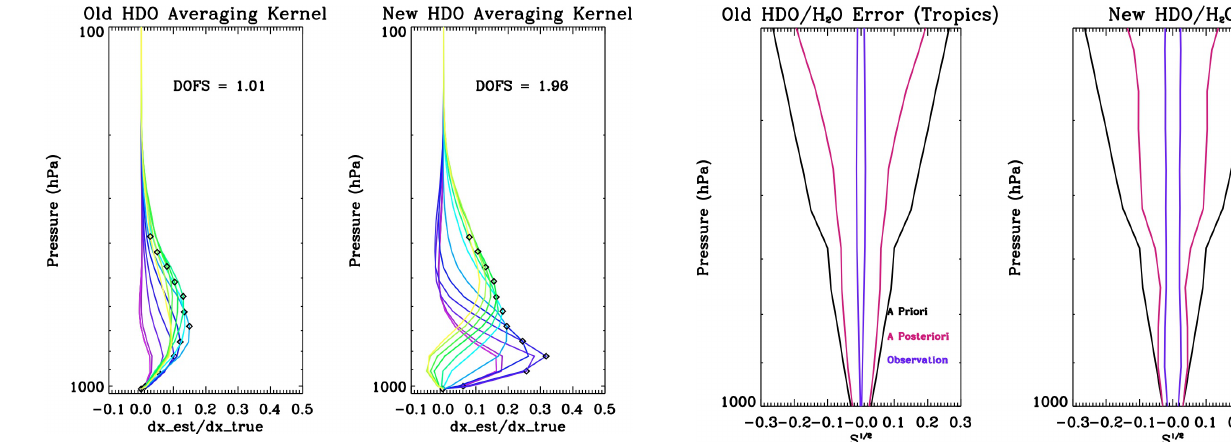
Figure 4a: Averaging kernel for the old and new HDO TES retrievals. As in Figure 2a, Fig. 4a. Averaging kernel for the old and new HDO TES retrievals. the symbols and colors indicate the pressure level and variation with pressure of As in Fig. 2a, the symbols and colors indicate the pressure level and each row of the averaging kernel matrix. variation with pressure of each row of the averaging kernel matrix.